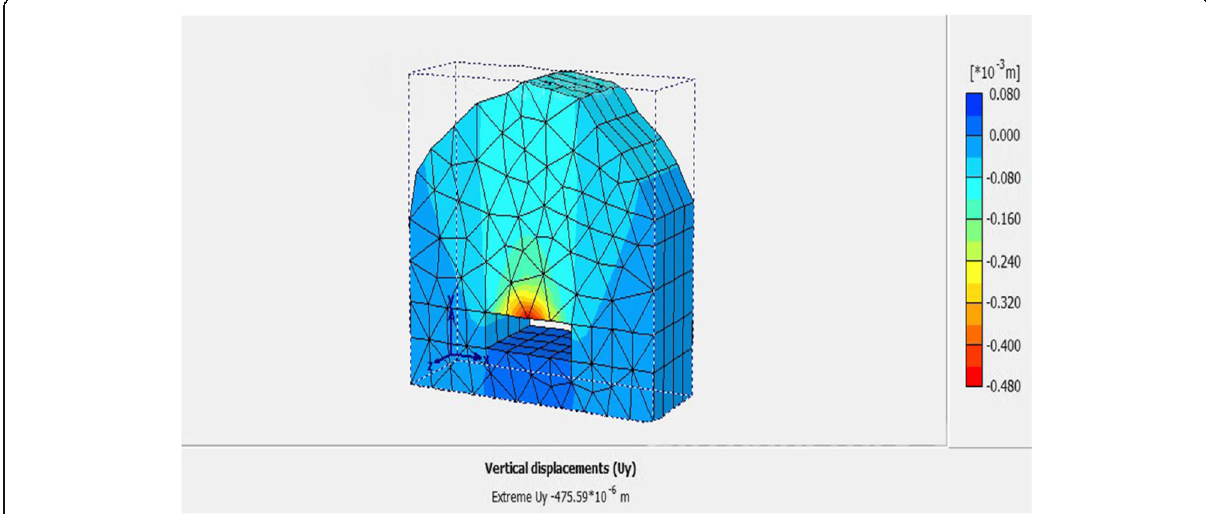
Fig. 32 Vertical displacement of the ceiling and sidewalls of northern Chamber. PLAXIS